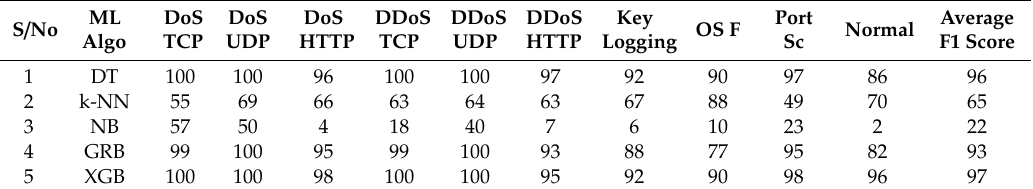
Table 11. F1 score summary of the multiclass classification.